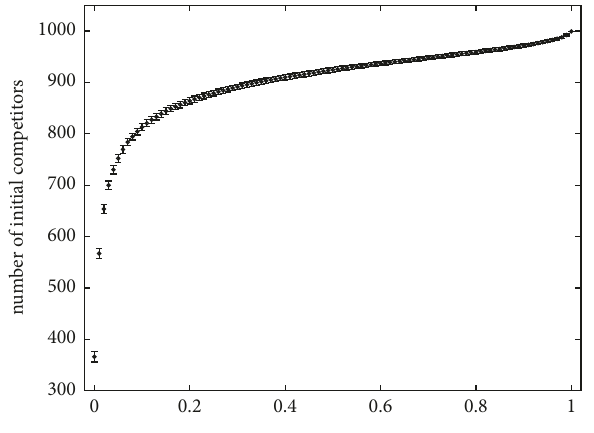
Figure 1: The number of initial competitors versus the weight of popularity, 𝑁 = 1000 ; the result is averaged over 100 realizations.